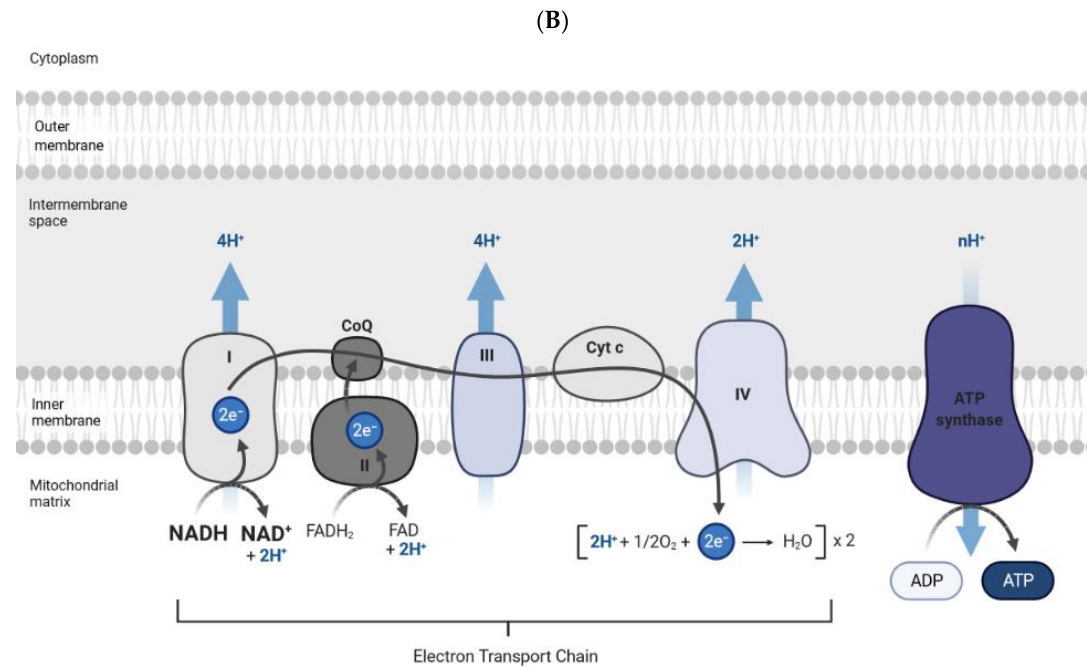
Figure 1. Impact of aging on NAD+ levels and oocyte number, and oocyte quality. ( A ) The blue line in the graph shows the gradual decline of the follicular pool, which is more enhanced after the age of 35 years in women. The oocytes in theses follicles are arrested in Prophase of the first meiotic division, and with advancing maternal age, oocytes’ mitochondria lose their function more and more. In consequence, NAD is less available, the oocyte has reduced quality and difficulties to defend against ROS. Sirt1 uses NAD+ as co-factor during the deacetylation of acetylated proteins. During this process nicotinamide is produced, which is then recycled back into NAD+. ( B ) Scheme showing the involvement of NADH/NAD+ in the electron transport chain which transports electrons along the mitochondrial membrane through the single complexes (I–IV). Abbreviations: ADP = adenosine diphosphate, ATP = adenosine triphosphate, CoQ = co-enzyme Q, Cyt c = cytochrome c, NAM = nicotinamide, NMN = nicotinamide mononucleotide, NAMPT= nicotinamide phosphoribosyl-transferase, NNMAT = nicotinamide mononucleotide adenylyl-transferase.